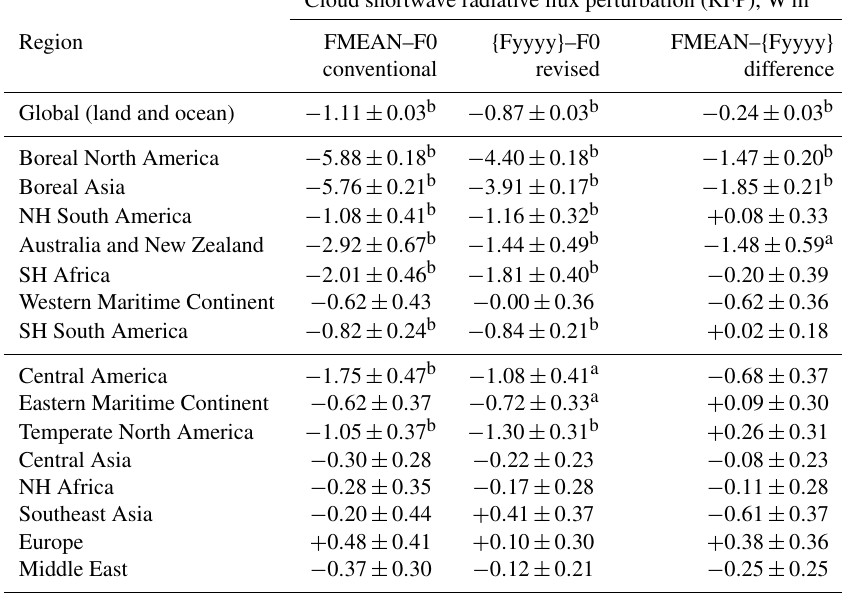
Table 2. Cloud shortwave top-of-atmosphere radiative flux perturbation (RFP) differences for different simulation combinations and regions. Combined standard errors have been calculated. Significance has been tested using Welch’s t test: a indicates differences that are statistically significant at two-tailed p < 0 . 05, and b indicates differences that are statistically significant at two-tailed p < 0 .